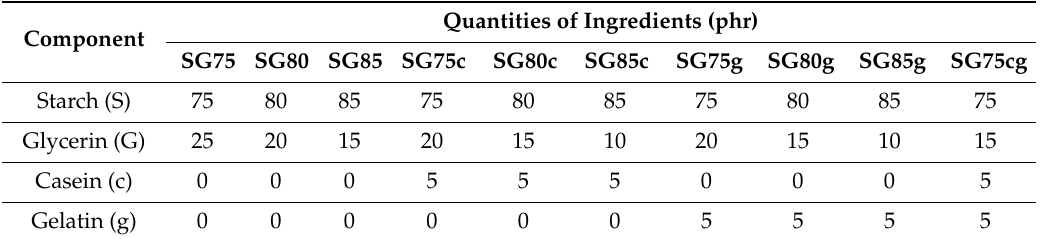
Table 1. Composition of starch films with gelatin or casein as a modifiers.